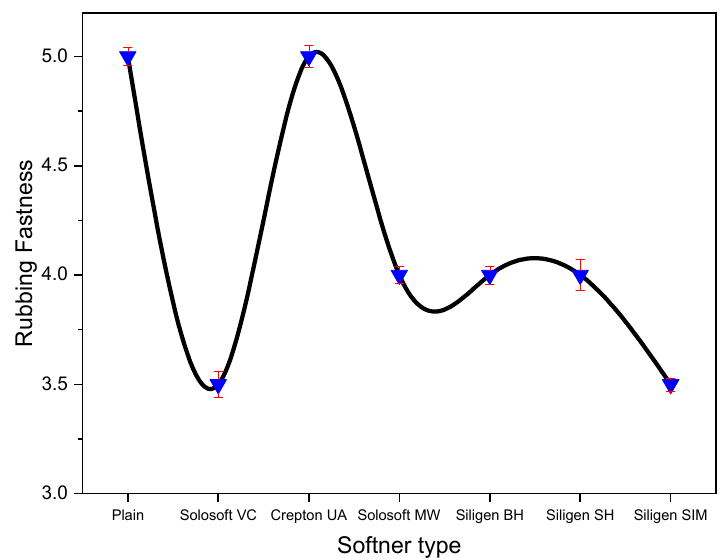
Figure 6. The rubbing fastness of terry knitted fabric with the application of different softeners.